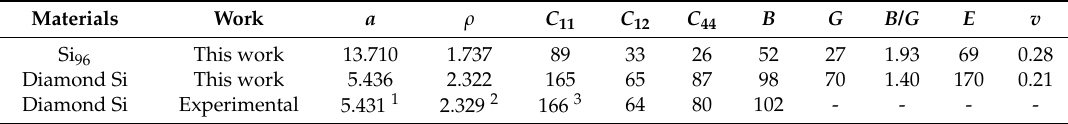
Table 1. The lattice parameters (Å), density ( ρ : g/cm 3 ), elastic constants (GPa) and elastic modulus (GPa) of Si 96 and diamond Si.